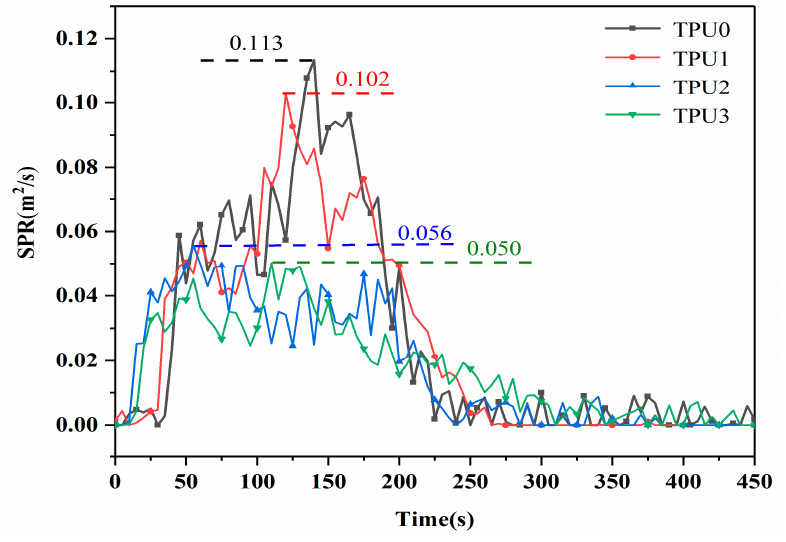
Figure 8. Smoke production rate curves of TPU composites.